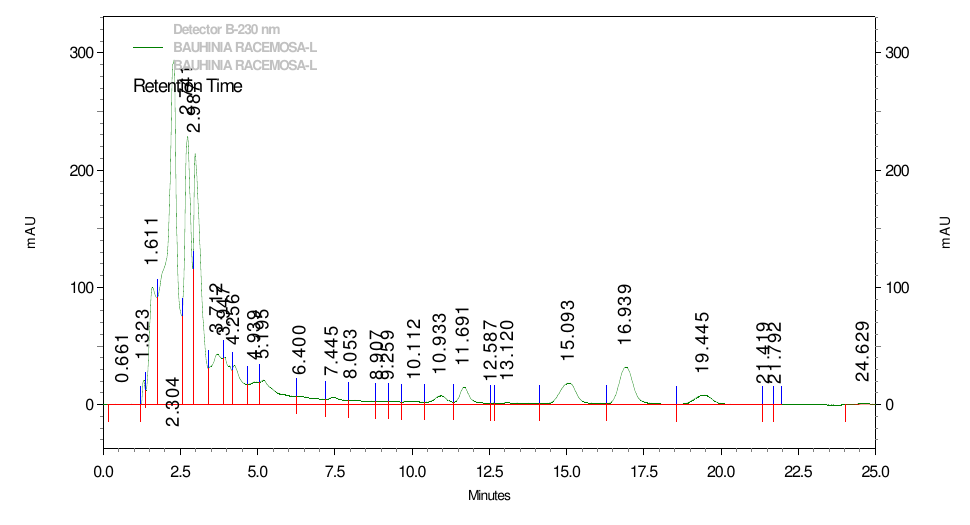
Figure 1 . HPLC finger print profile of ethanolic extract of Bauhinia racemosa leaves